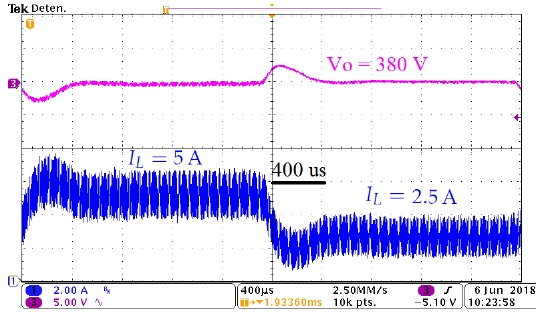
Figure 22. Response to a 50% step change in the power P from experimental